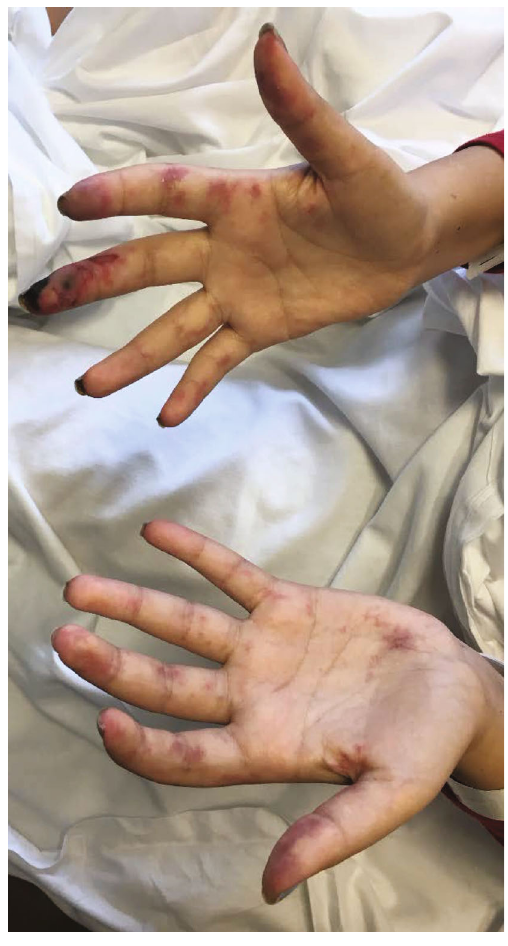
Figure 1: Lupus vasculitis, with digital ischemia and mesenteric ischemia, ultimately resulting in perforated